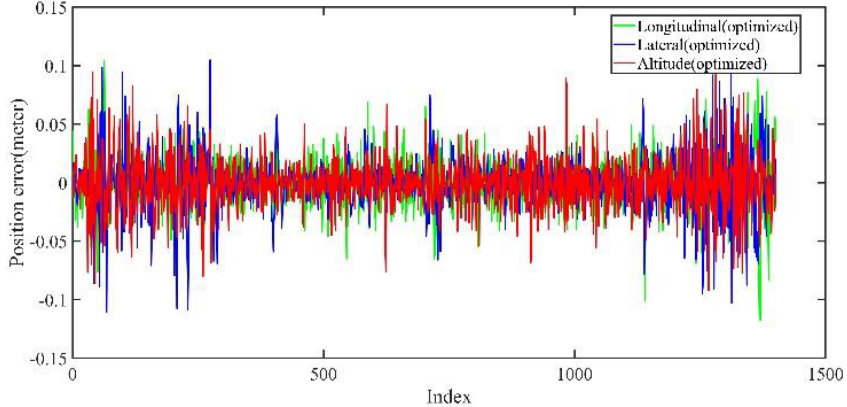
Figure 19. Large scale scenario optimized mapping trajectory position error in longitudinal, lateral, and altitude directions. After optimization, the error is at the centimeter level.